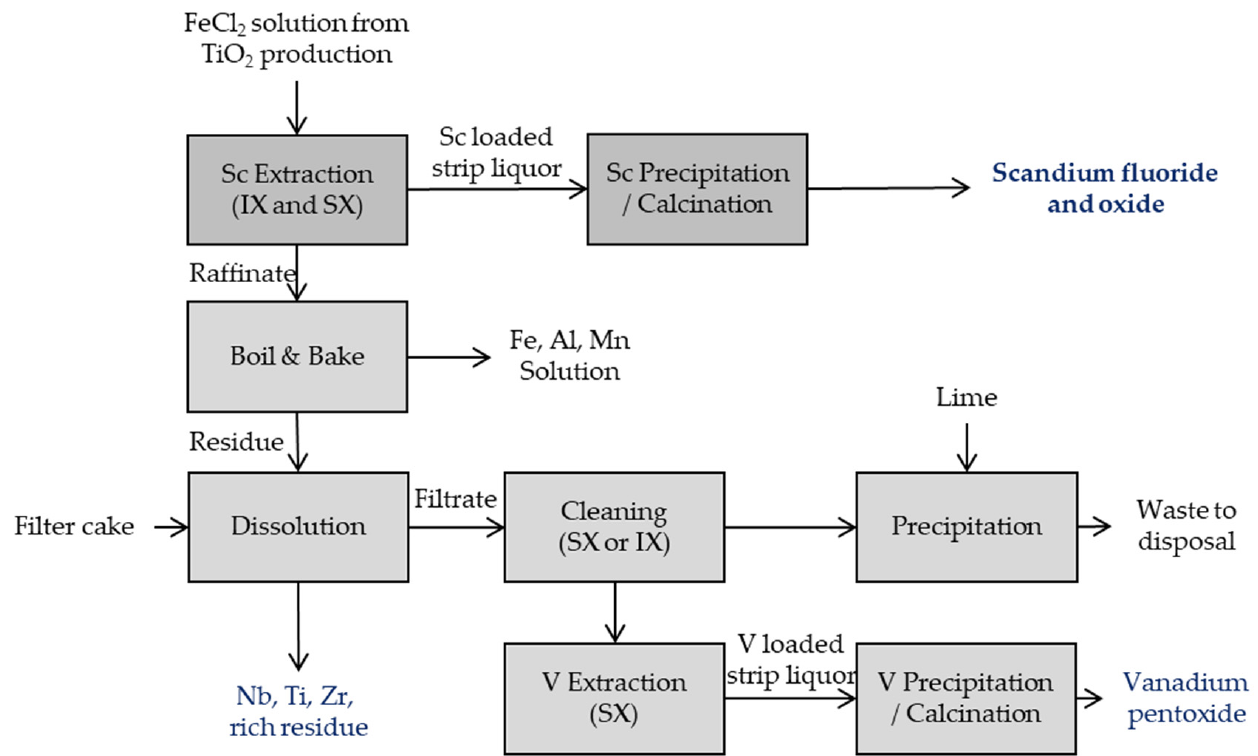
Figure 1. Conceptual process flow sheet of ScaVanger.